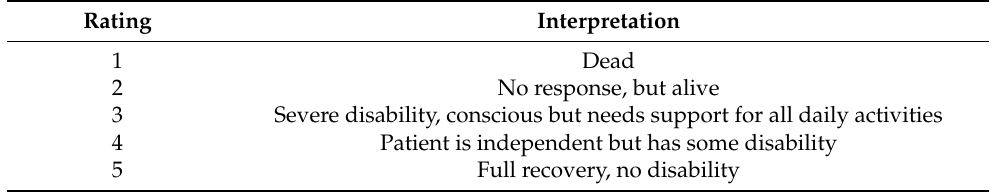
Table 1. The Glasgow Outcome